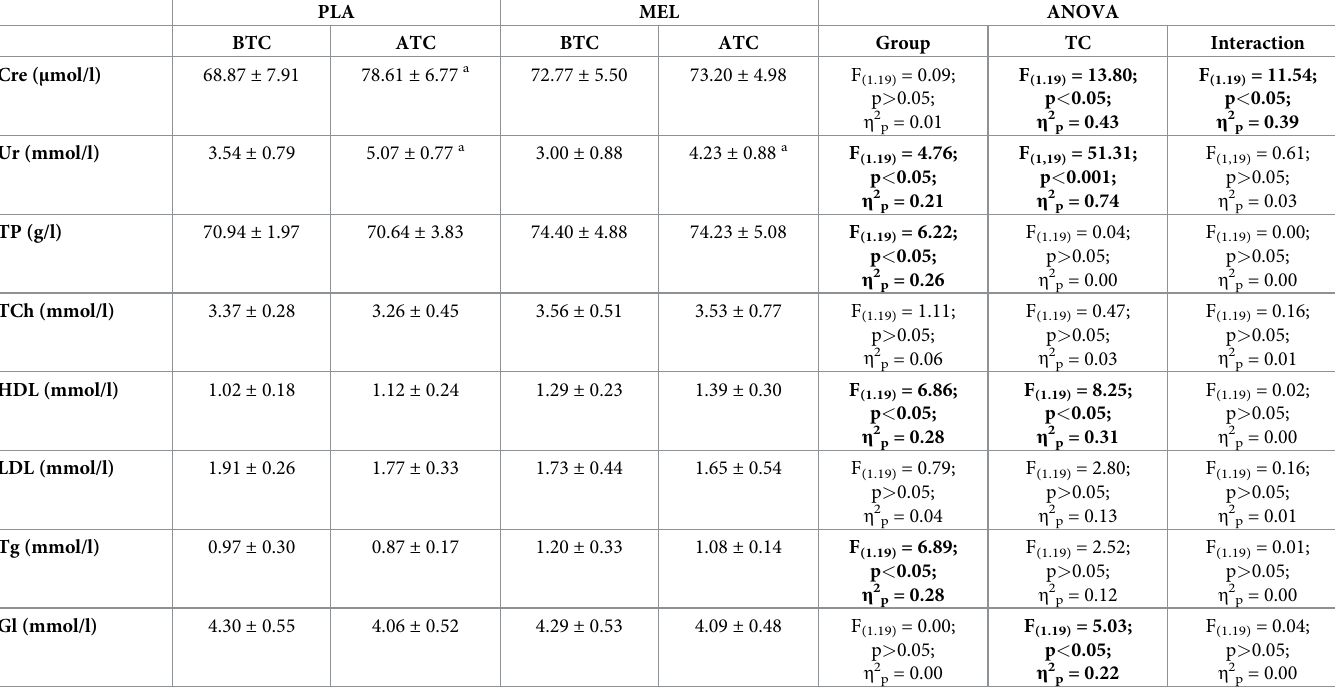
Table 3. Metabolic parameters measured before (BTC) and after (ATC) the training camp (TC) following melatonin (MEL) or placebo (PLA) ingestion. PLA MEL ANOVA Group